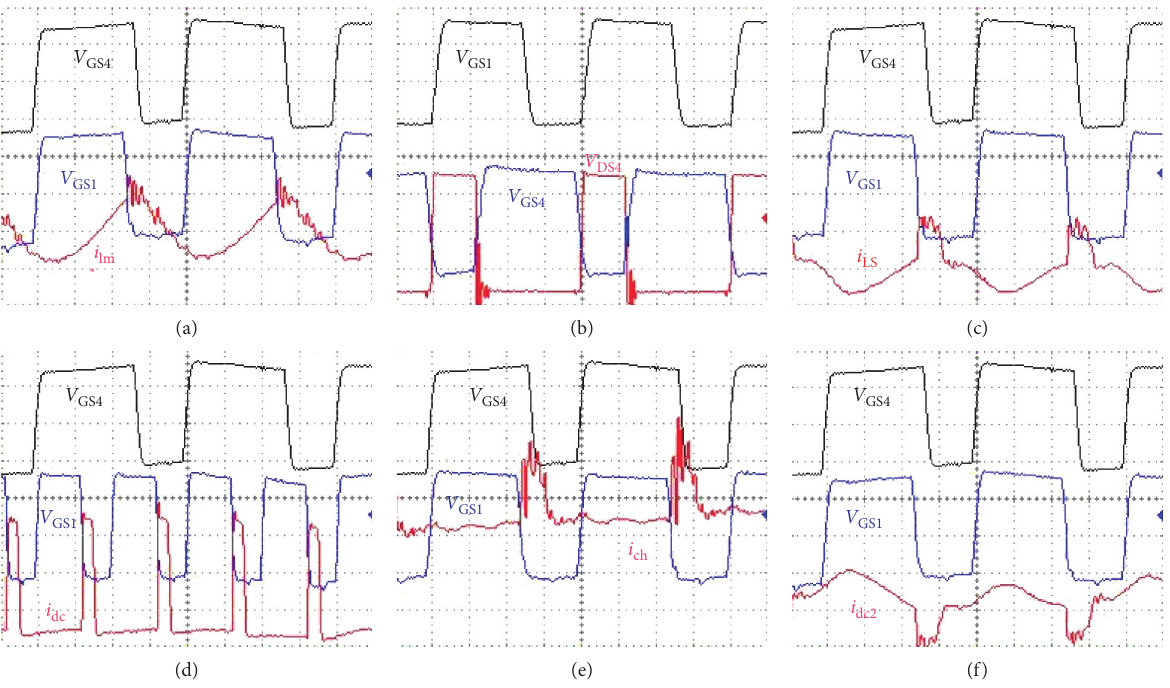
and V and magnetizing current i GS1 GS4 i V of switch S and V and secondary current i b . (c) Gate signals DS4 4 GS1 GS4 and V and current i of diode D . (f) Gate signals V GS1 GS4 ch ch